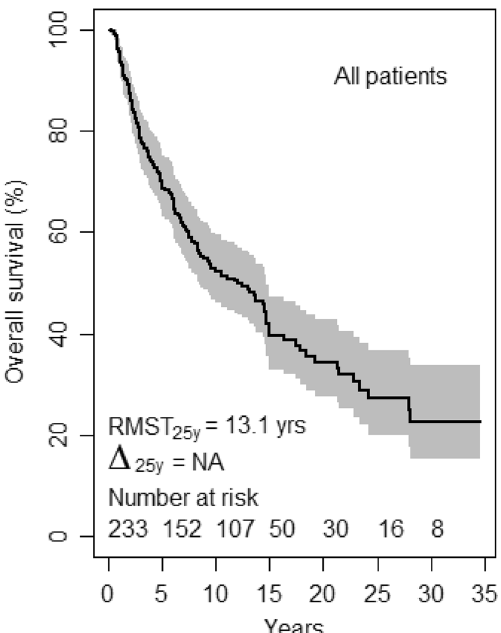
Figure 1. Overall survival, all patients. RMST 25y , restricted mean survival time at 25 years time horizon. Δ 25y , Gini’s mean difference of the RMST. NA, not applicable.